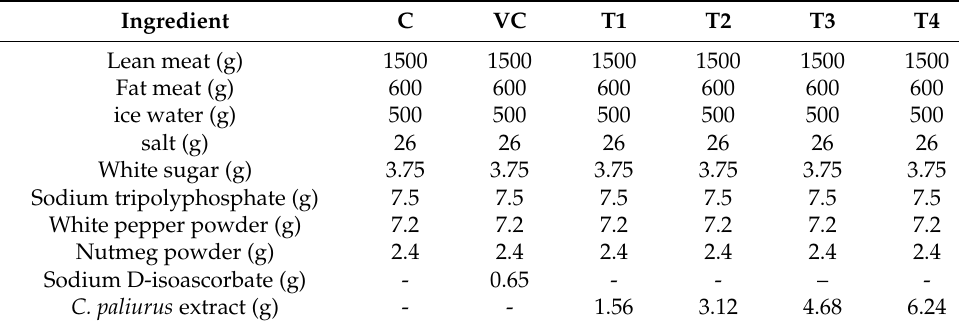
Table 1. Ingredients of raw-cooked meat products